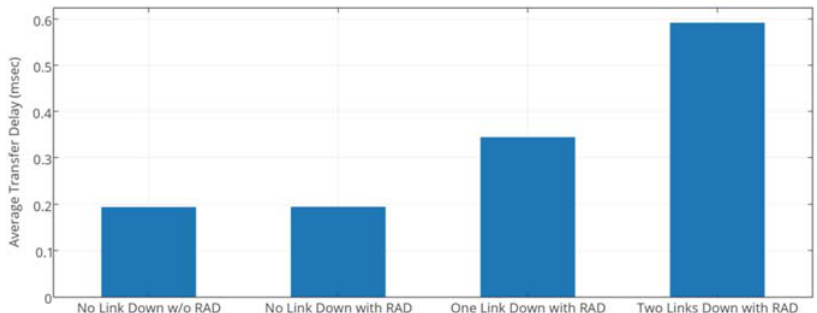
Appl. Sci. 2017 , 7 , 266 Figure 6. Average transfer delay (ms) vs. the number of links down. Figure 6. Average transfer delay (ms) vs. the number of links down.